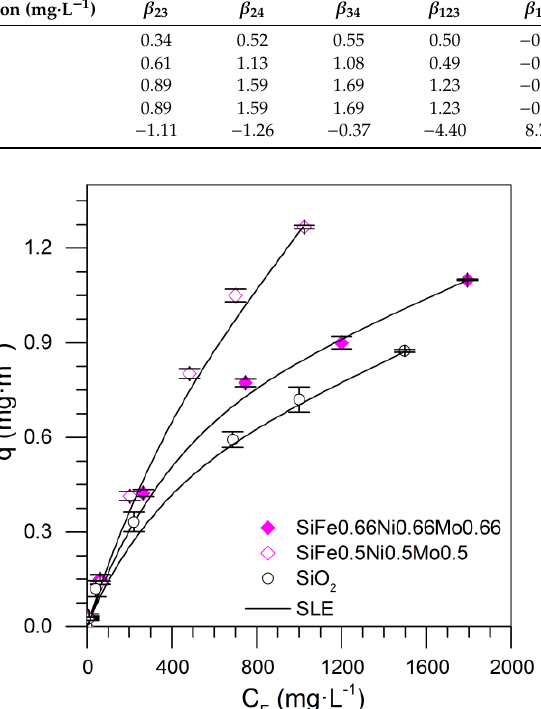
Figure 14. Asphaltene adsorption isotherms for nanoparticles SiO 2 , SiFe0.5Ni0.5Mo0.5, and SiFe0.66Ni0.66Mo0.66 at 25 ◦ C. The symbols are experimental data, and the solid lines are from the SLE model.